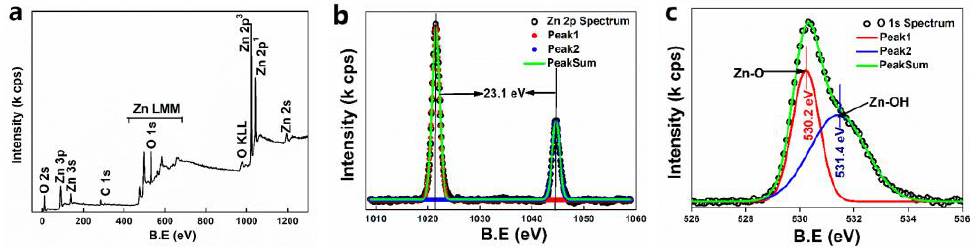
Figure 7. ( a ) Wide range XPS spectra of ZnO NPs; ( b ) high-resolution spectra of Zn 2p; ( c) high- resolution spectra of